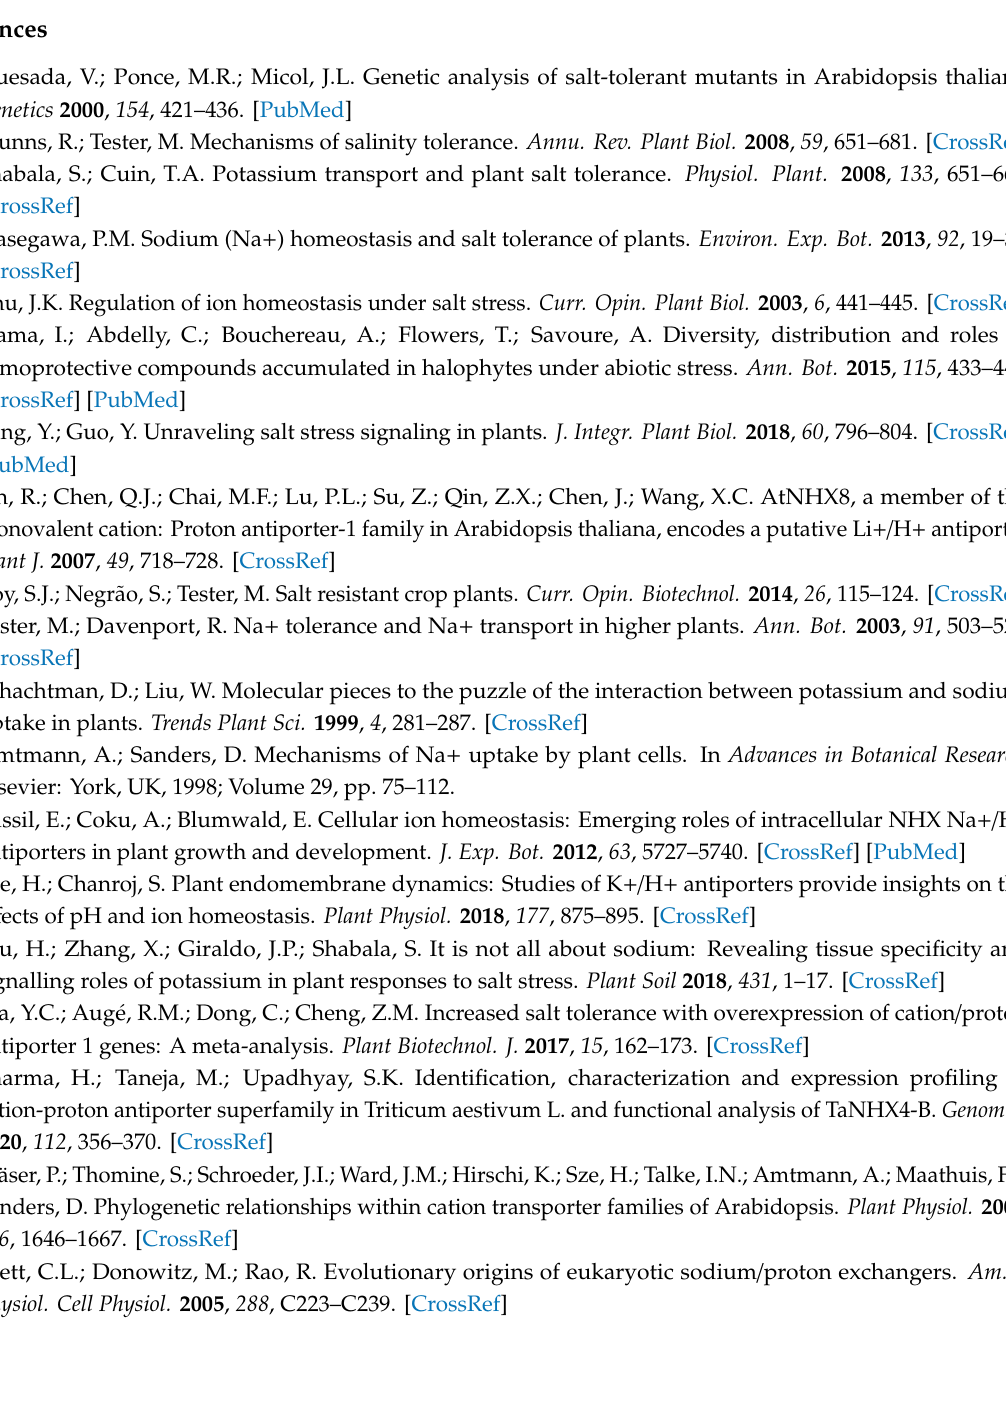
Structure for GbNHX and GhNHX . Figure S3: Sequence logos of four cotton species. Figure S4: Amiloride binding site in NHX genes. Figure S5: Chromosomal map four for Gossypium species. Figure S6: Gb , Ga and Gr NHX genes phylogenetic tree. Figure S7: Single protein-protein Interaction. Figure S8: GO terms